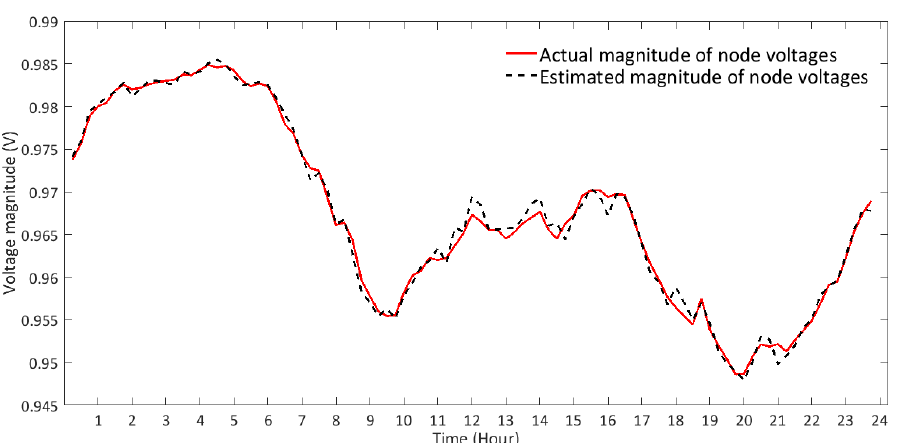
Figure 11. The estimated and actual values of the last node voltage (sunny